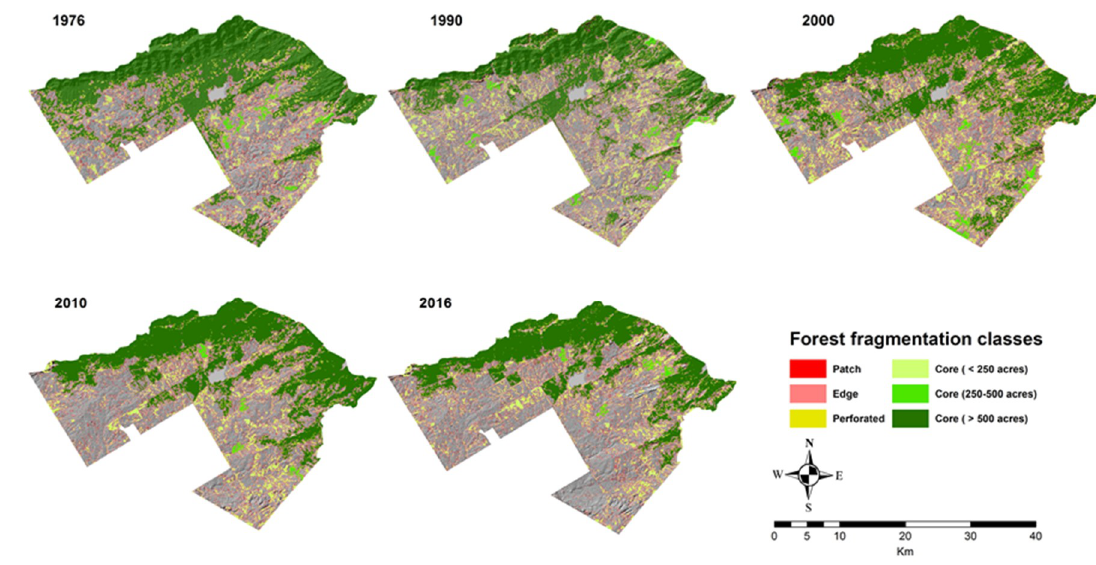
Figure 5. Forest fragmentation maps for 1976, 1990, 2000, 2010, and 2016.